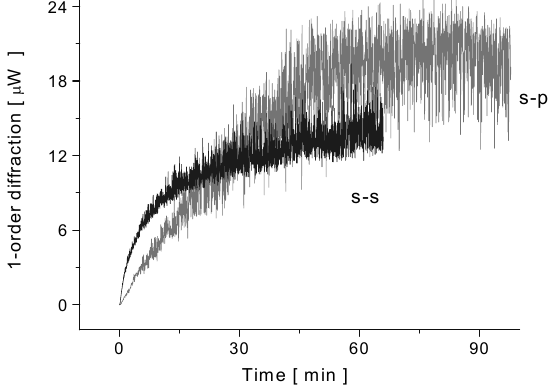
Fig. 3 An example of kinetics of grating recording in poly(amide-imide) (3d) with double N=N bond for s − p and s − s polarization